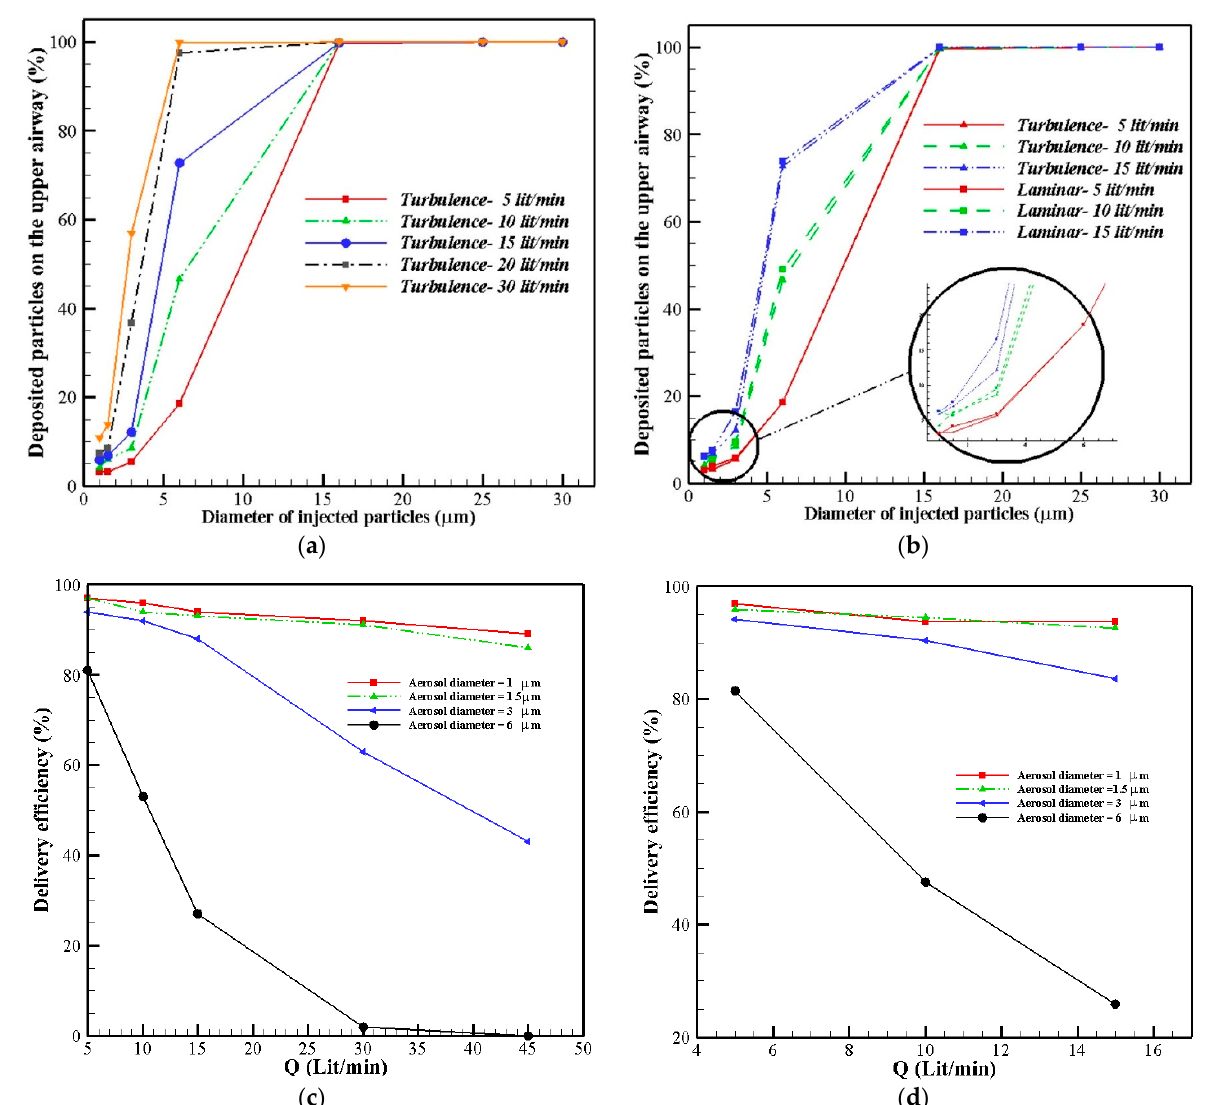
Figure 12. Deposition percentage (DE %), pattern, and drug delivery efficiency of aerosols to the lungs. ( a ) Deposition fraction pattern for turbulence SST model; ( b ) comparison between deposition fractions of the laminar and SST models; ( c ) drug delivery efficiency to the lungs; ( d ) drug delivery efficiency to the lungs.